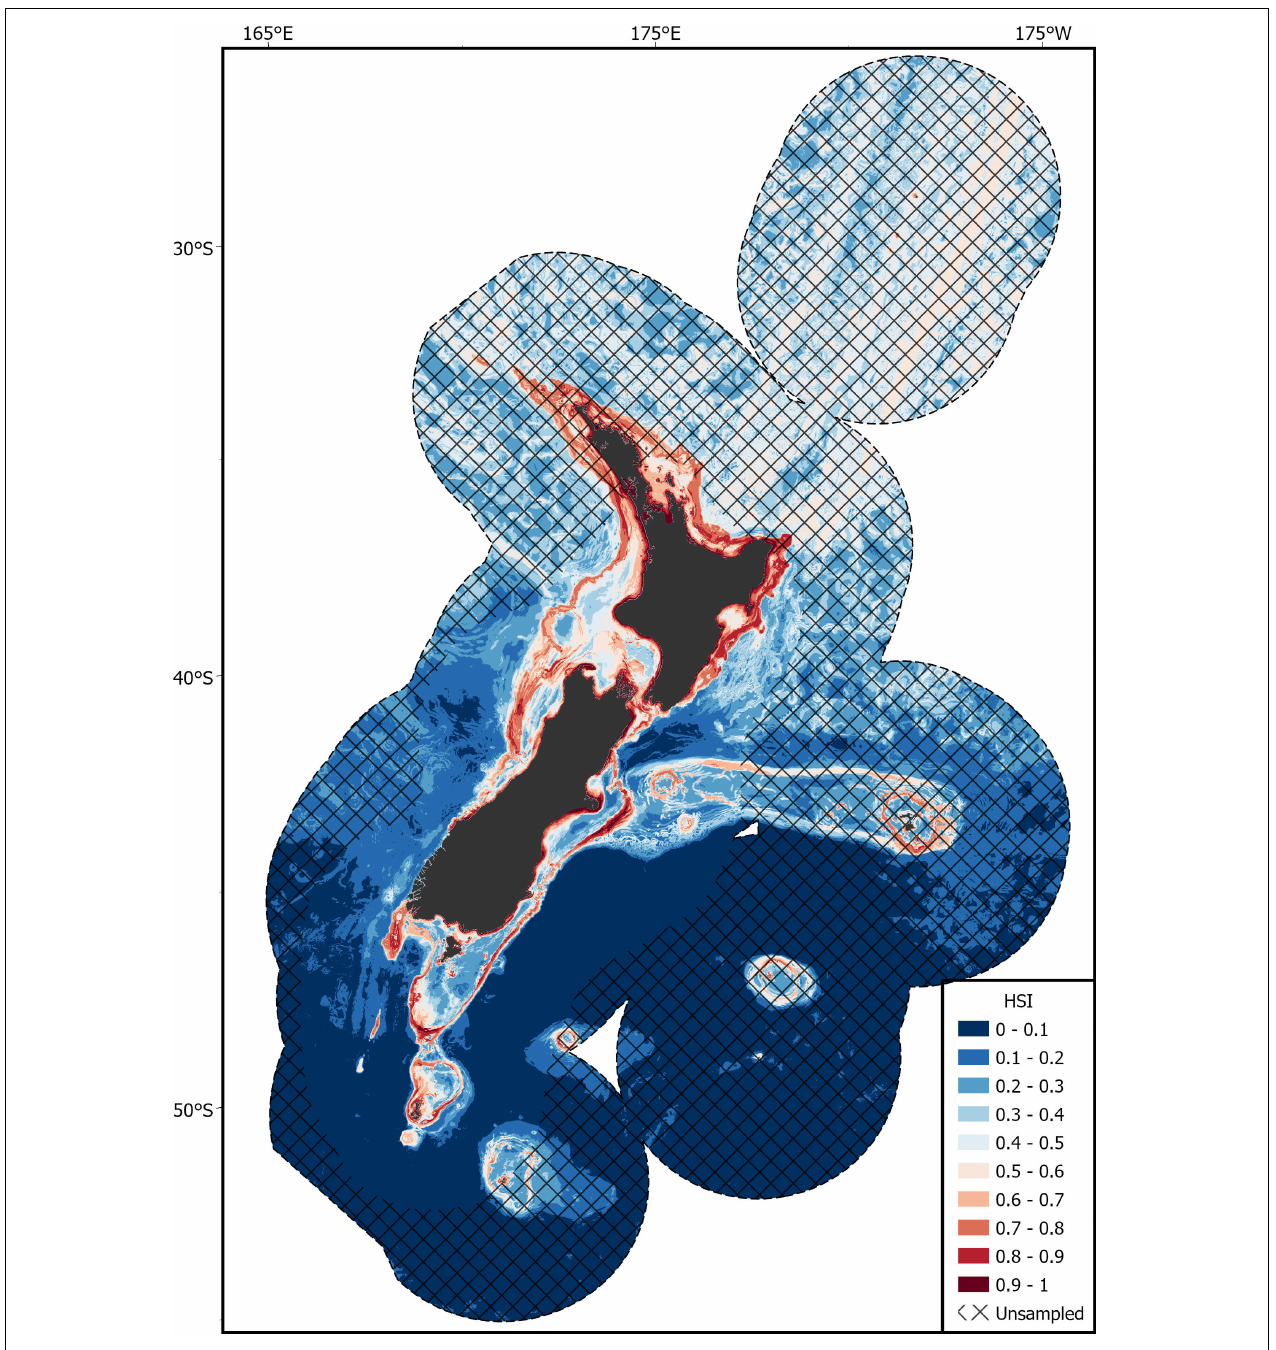
FIGURE 4 | The predicted habitat suitability index (HSI) of basking shark in the New Zealand Exclusive Economic Zone (EEZ) from 1889 to 2020 modeled using the bootstrapped ensemble models. Areas outside 95% kernel density estimate (KDE) probability grid indicating lower confidence that can be placed in the predicted probability occurrence are covered by crossed black